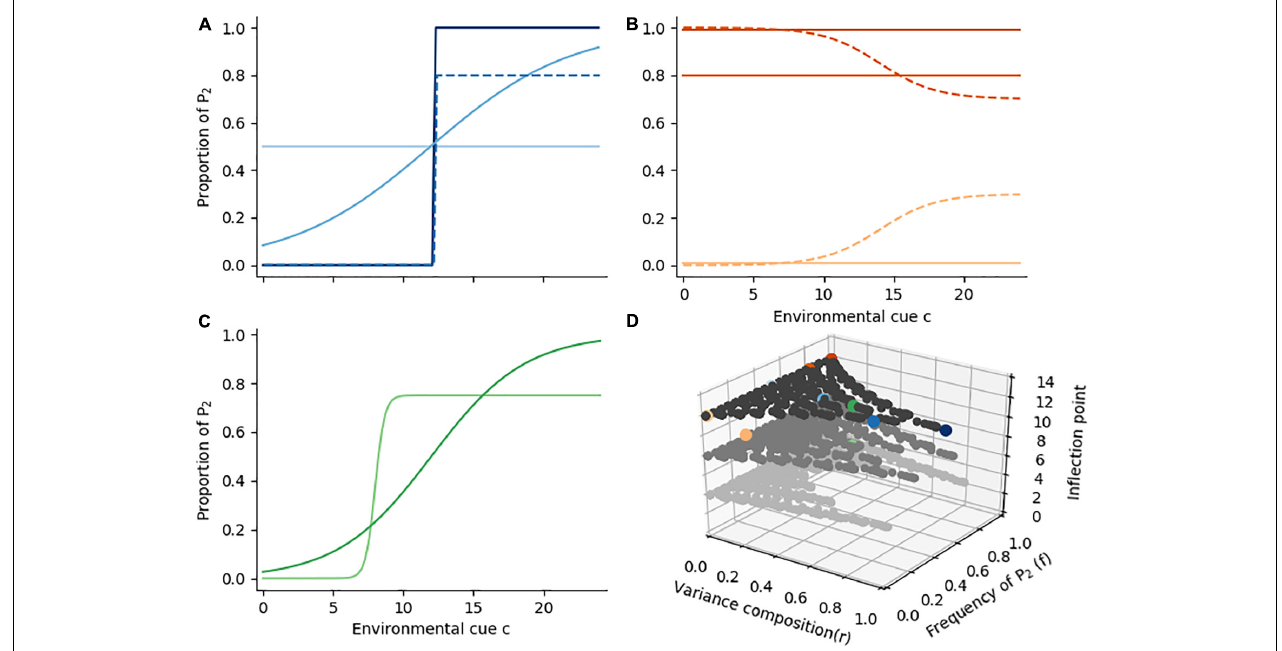
FIGURE 3 | Example reaction norm shapes. (A) Four reaction norm shapes that exhibit high phenotypic variance. Variance may occur exclusively among environments (dark blue), exclusively within each environment (light blue), or as a mix of both variance components (medium blue, solid and dashed). We refer to the ratio of the variance components (among : within) as r. (B) Three different reaction norms with r = 0 (solid lines), and two different reaction norms with r = 0.14 (dashed). The reaction norms differ in the mean frequency f of phenotype P 2 , which also affects the phenotypic variance s (i.e., the sum of variance among and within environments). Reaction norms with f = 0 (light orange) and f = 1 (dark orange) are canalized ( s = 0), and phenotypic variance is maximized at f = 0.5 (see panel A ). (C) Two logistic reaction norms with the same f and r , but different inflection points. (D) possible parameter space of r , f, and inflection points. Gray dots depict sample reaction norms across the range of possible parameters (darkness scales with z-axis), colored dots indicated samples from panels (A–C) in their respective